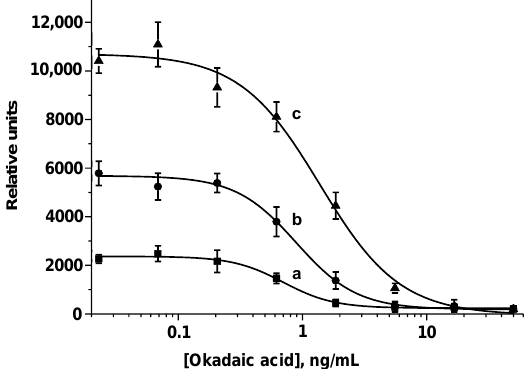
Figure 5. Calibration curves of OA in the standard LFIA ( a ) and in the enhanced LFIA with 2 ( b ) and 3 ( c ) amplification cycles ( n = 3).